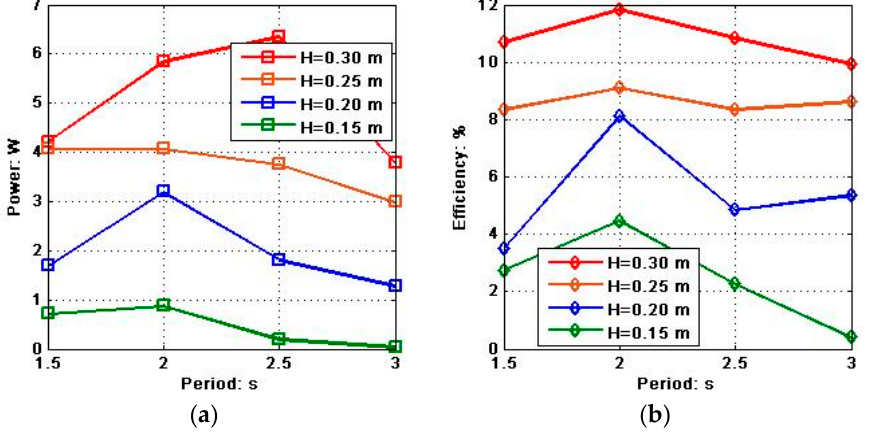
Figure 18. Generation performance of the ACWEC with different wave periods, M 1 = 20.11 kg: ( a ) power curve; ( b ) efficiency curve.